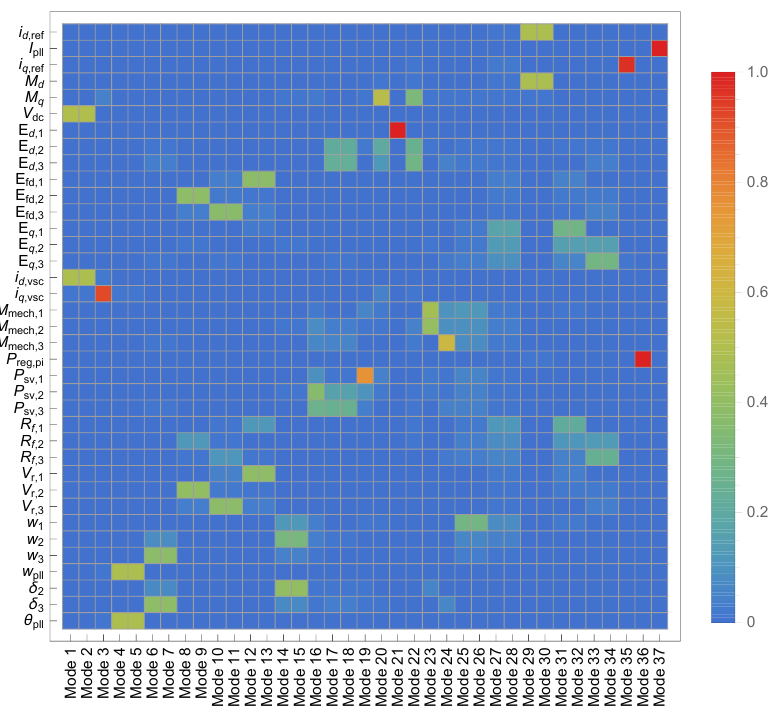
Figure A2. IEEE 9 bus: Matrix of Participation factors for the system with vector control.